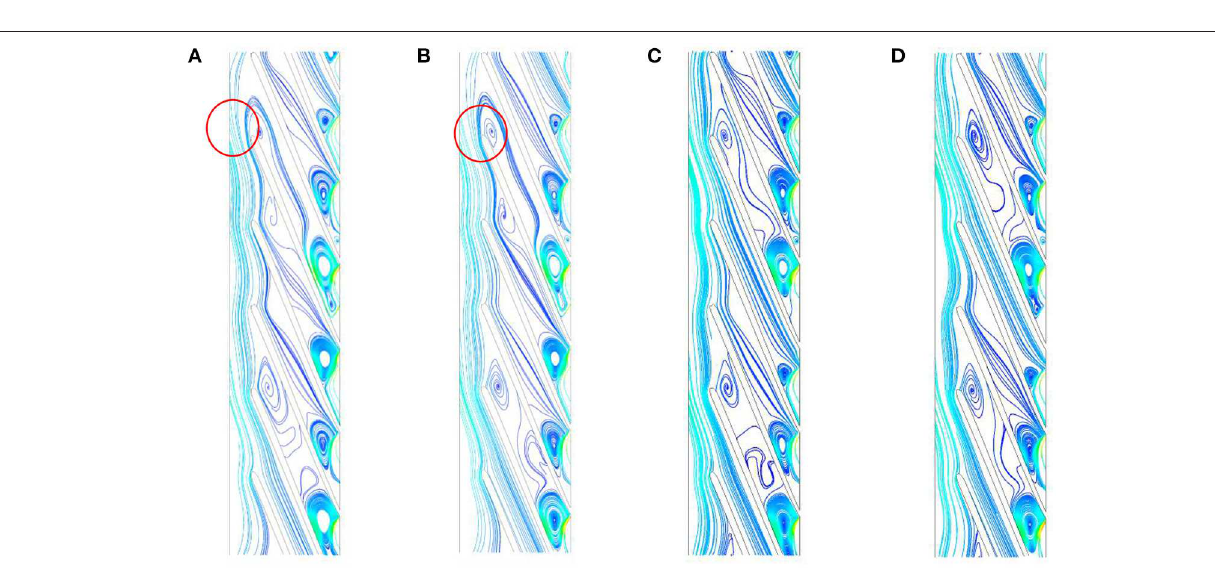
open-valve transition is higher than that in the steady state of the same flow